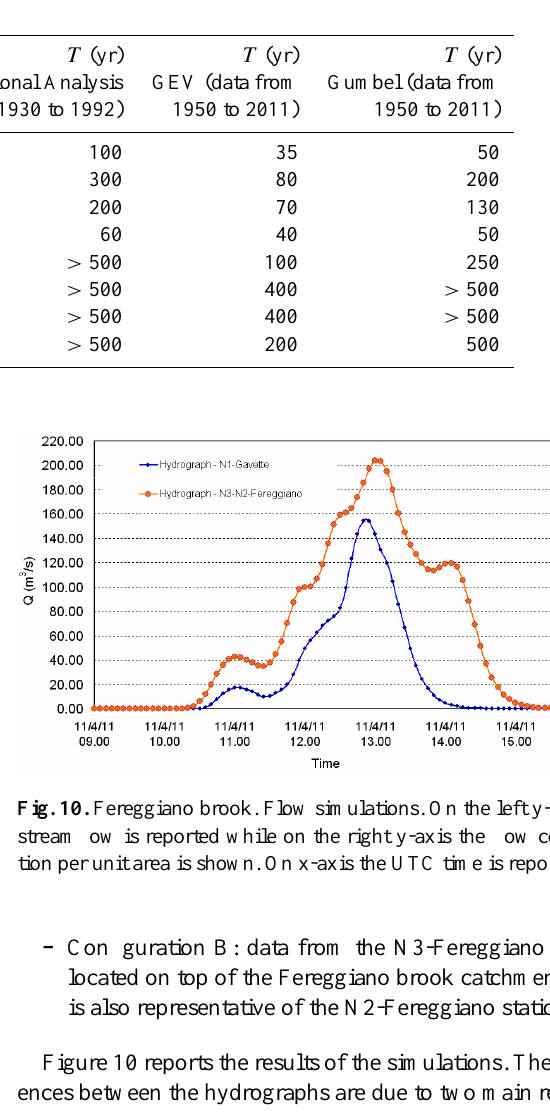
Table 1. Return period T of the rain depth observed, during four standard durations by the three rain gauges presented in Fig. 6, as estimated following the three different methods highlighted in the text.